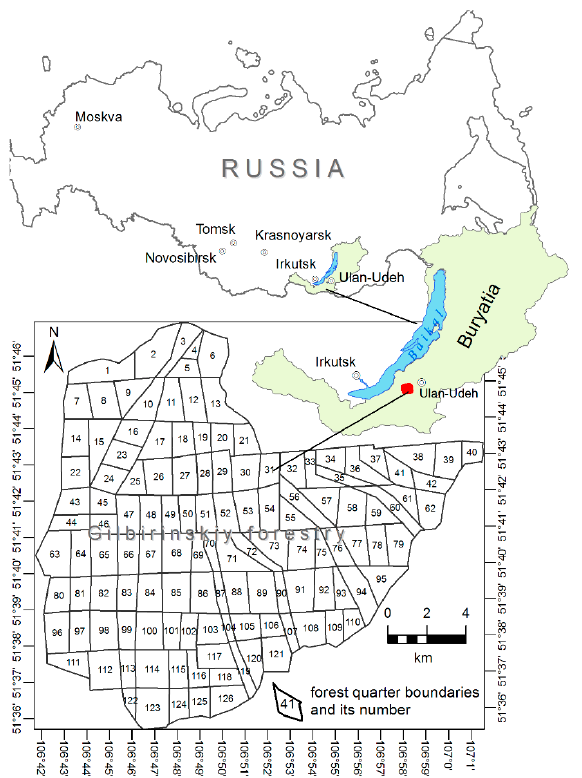
Figure 1. The study area (Gilbirinskiy forestland, Republic of Buryatia, Russia)